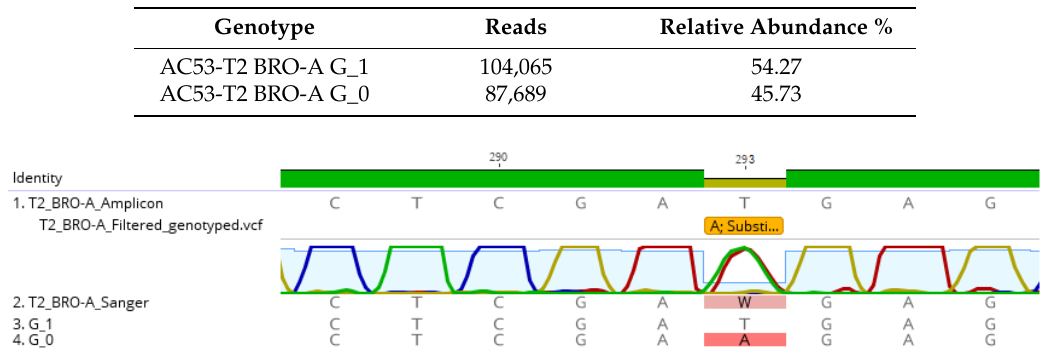
Table 3. Relative abundance of the two BRO-A genotypes within AC53-T2 BRO-A.